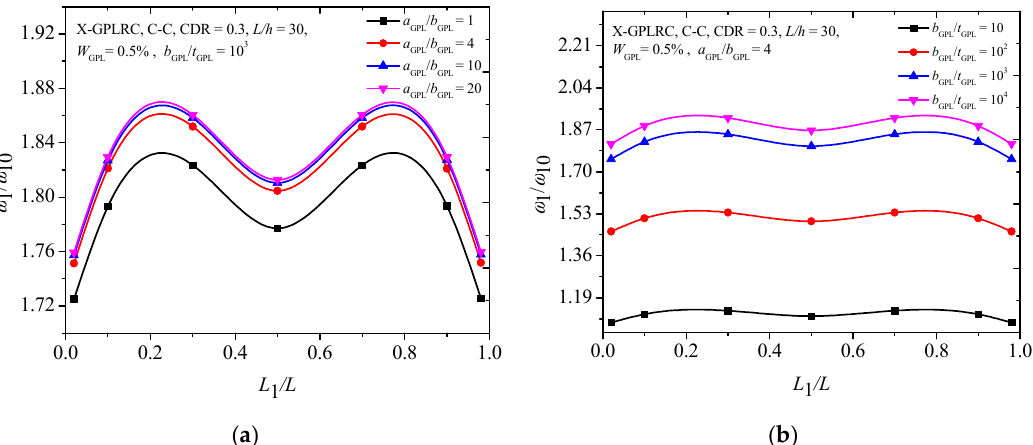
Figure 4. Effects of ( a ) aspect ratio ( b ) width-to-thickness ratio on the fundamental frequency of the C-C cracked FG-X-GPLRC beam.